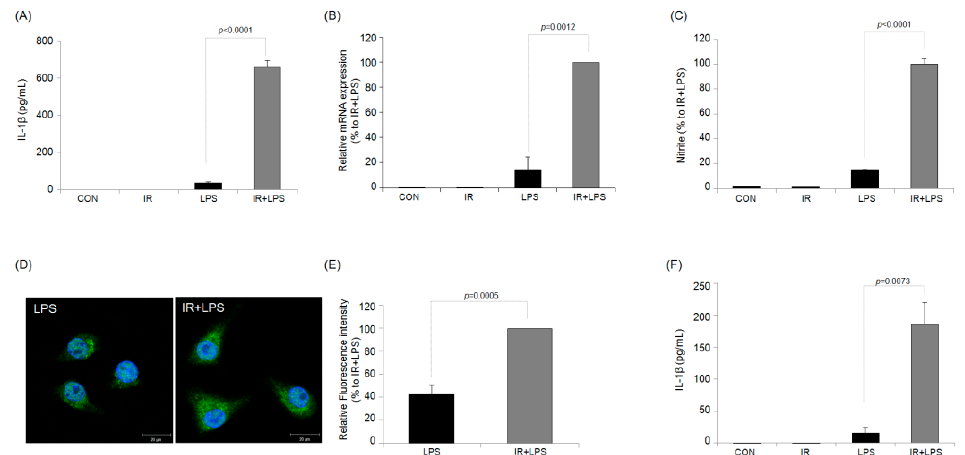
Figure 2. Ionizing radiation (IR) potentiates the IL-1 β production of RAW264.7 macrophages and primary cultured peritoneal macrophages in response to lipopolysaccharide (LPS). RAW264.7 (2 × 10 5 cells/mL) cells were irradiated (5 Gy) using a blood gamma irradiator. After 24 h, the cells were treated with LPS (0.1 µ g/mL). After another 24 h, the supernatant was used for IL-1 β ( A ) or nitrite (NO 2 − ) ( C ) determination. ( B ) Measurement of the mRNA level of IL-1 β in the different treatment groups. ( D , E ) Representative confocal microscopy image for intracellular IL-1 β detection of LPS only- and IR + LPS-treated macrophages and fluorescence analysis data. ( F ) Primary cultured peritoneal macrophage (5 × 10 5 cells/mL) cells were irradiated (5 Gy) using a blood gamma irradiator. After 24 h, the cells were treated with LPS (0.1 µ g/mL). After another 24 h, the supernatant was used for IL-1 β .